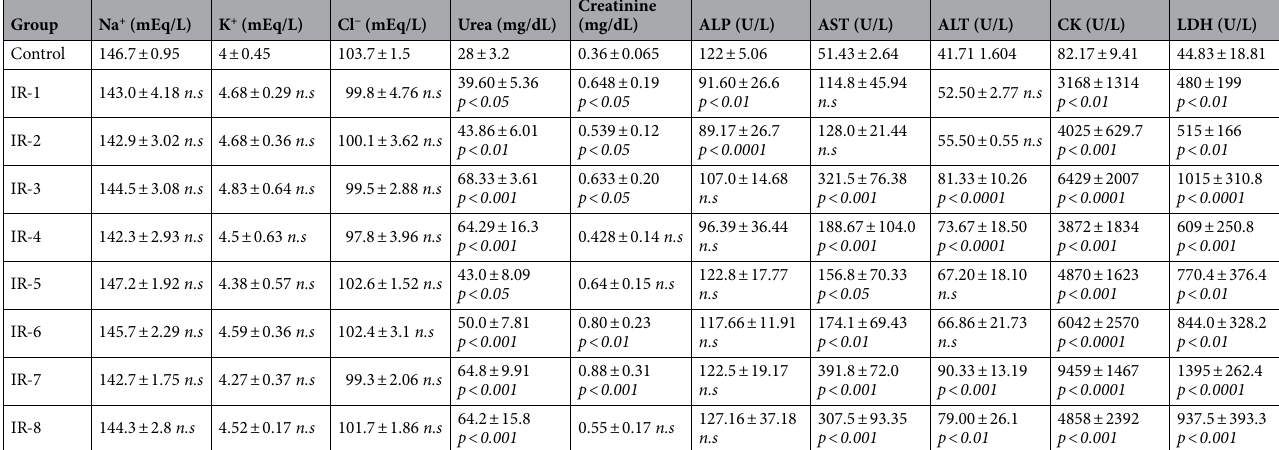
Table 1. Results of biochemical analysis and levels of electrolytes in serum. Data are presented as the mean, the corresponding standard deviation (SD) and the p value from comparison with the reference value of the control group (first line), considering p values < 0.05 to be significant. ALP alkaline phosphatase, AST aspartate aminotransferase, ALT alanine aminotransferase, CK creatine kinase, LDH lactate